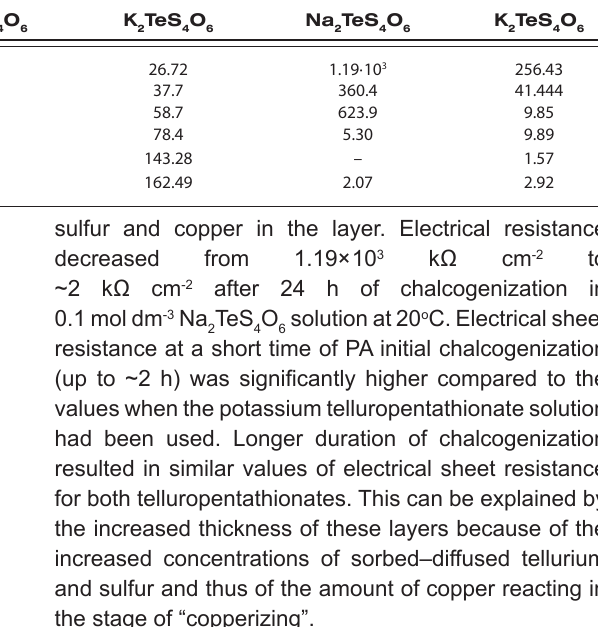
Chalcogenization duration, h